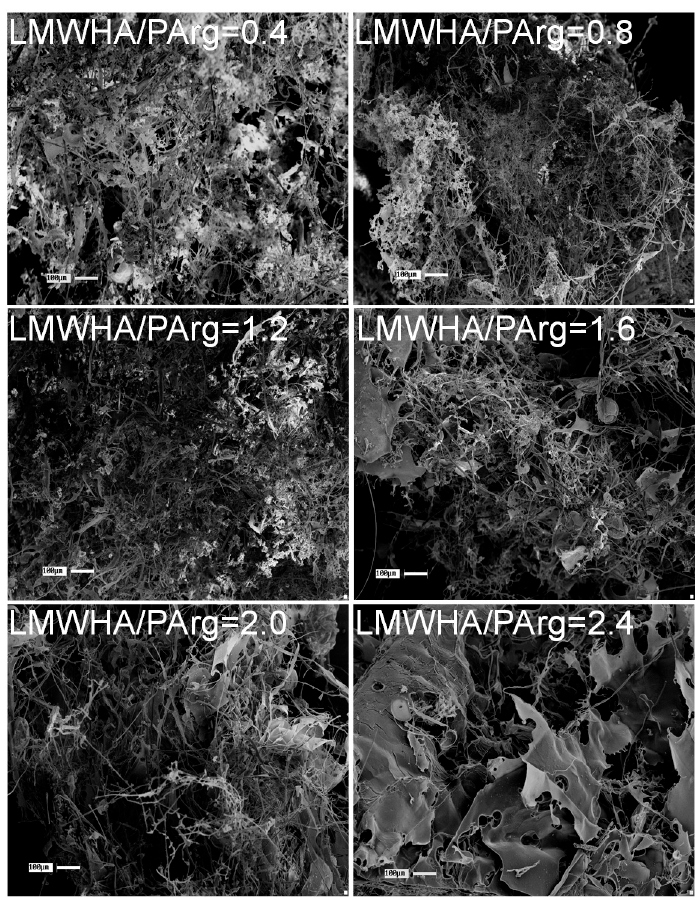
Figure 4. SEM images of materials obtained after freeze-drying 9 mL of INC containing LMWHA and PArg at different ratios of 0.4, 0.8, 1.2, 1.6, 2.0, and 2.4 in cylindrical plastic containers with 38 mm diameter. Scale bar of 100 mm.